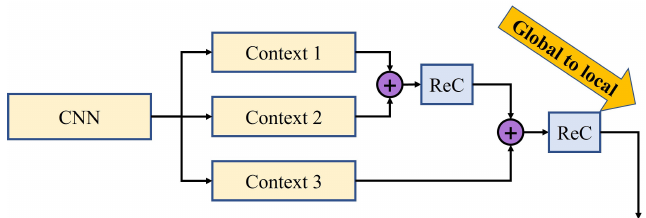
Figure 11. Multi-scale contextual information aggregation